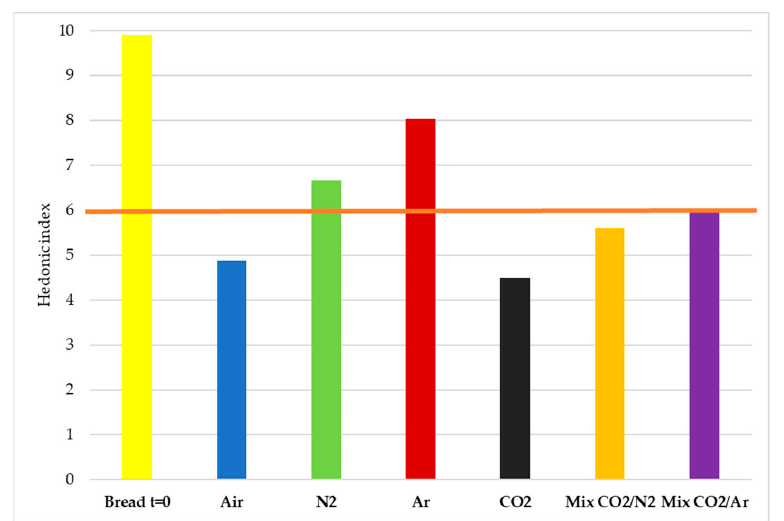
Figure 6. Hedonic index of the bread at time zero and after 8 days of storage in the different MAPs. The orange line indicates the acceptability limit value taken as a reference for this parameter.